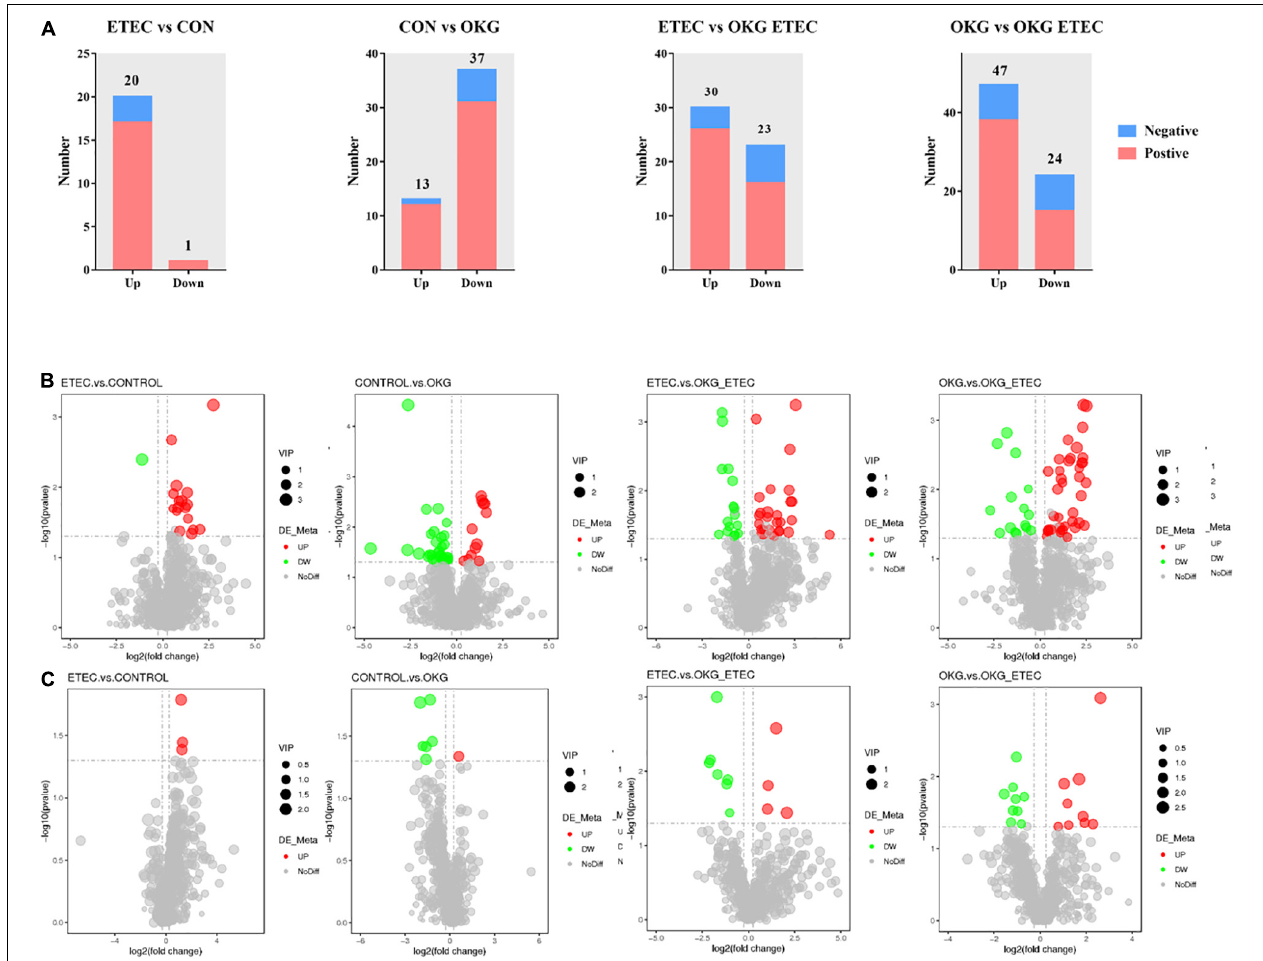
FIGURE 6 | Effects of OKG supplementation on ileal mucosa metabolites in ETEC- infected pigs. (A) The number of differentially expressed metabolites with functional annotations ( p < 0.05 and VIP > 1) in the four groups of piglets. (B,C) Volcano plots in differential metabolites, red or green spots indicate a statistically significant up-regulation or down-regulation in the four pairwise comparisons (ETEC vs. CON, CON vs. OKG, ETEC vs. OKG ETEC, and OKG vs. OKG